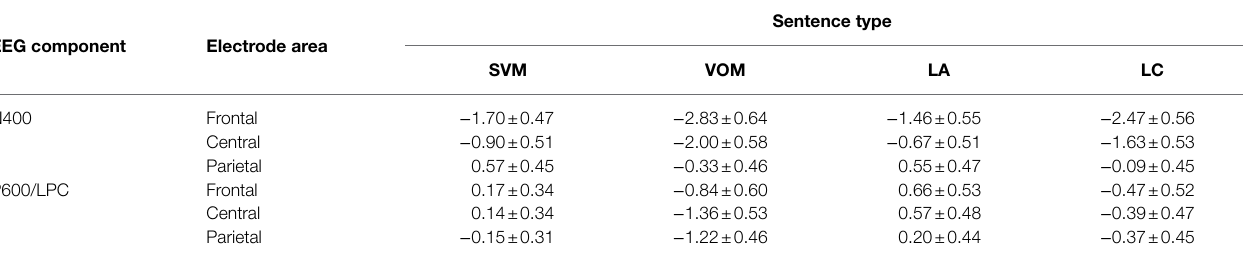
TABLE 2 | Mean amplitude ( μ V ) and standard deviation ( SD ) of N400 and P600/LPC for target verb.